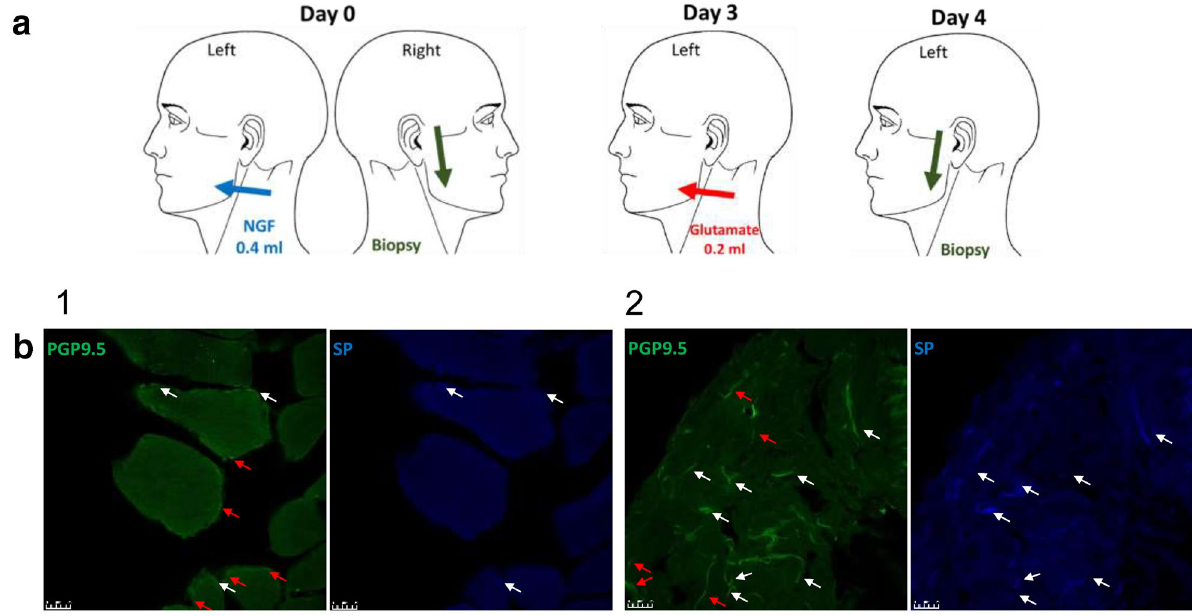
Figure 1. Figure displaying the methodology of the study. ( a ) Glutamate was injected three days after NGF into the left masseter muscle. One day after injection, a microbiopsy was taken from the injection site. ( b ) The left photomicrograph shows example image of PGP9.5 staining (green) while the right one shows SP expressing nerve fibers (blue) (1) associated with myocytes and (2) within connective tissue from one female participant on day 4. The white arrows indicate positive PGP 9.5 immunofluorescence signals co-expressed with positive SP signals, while the red arrows indicate positive PGP 9.5 signals without SP co-expression. Green: PGP 9.5, Blue: SP, Scale bar = 25 µm.